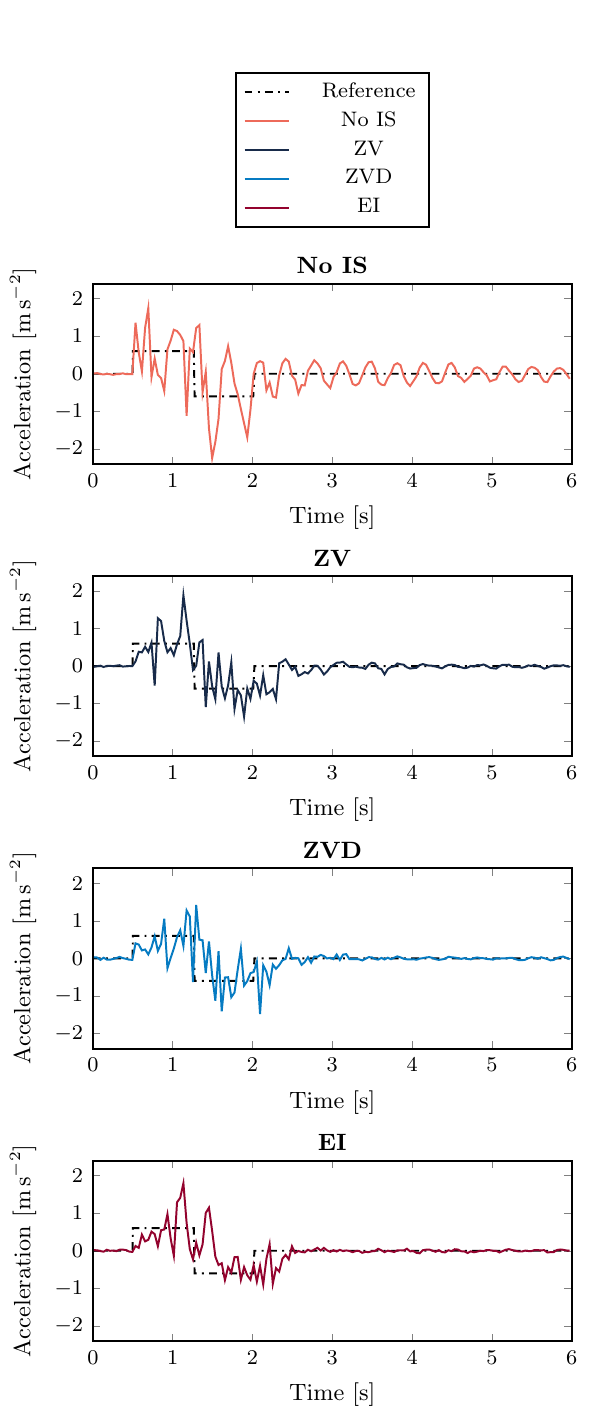
Figure 9: Acceleration measurements performed by an accelerometer placed right next to the 3D